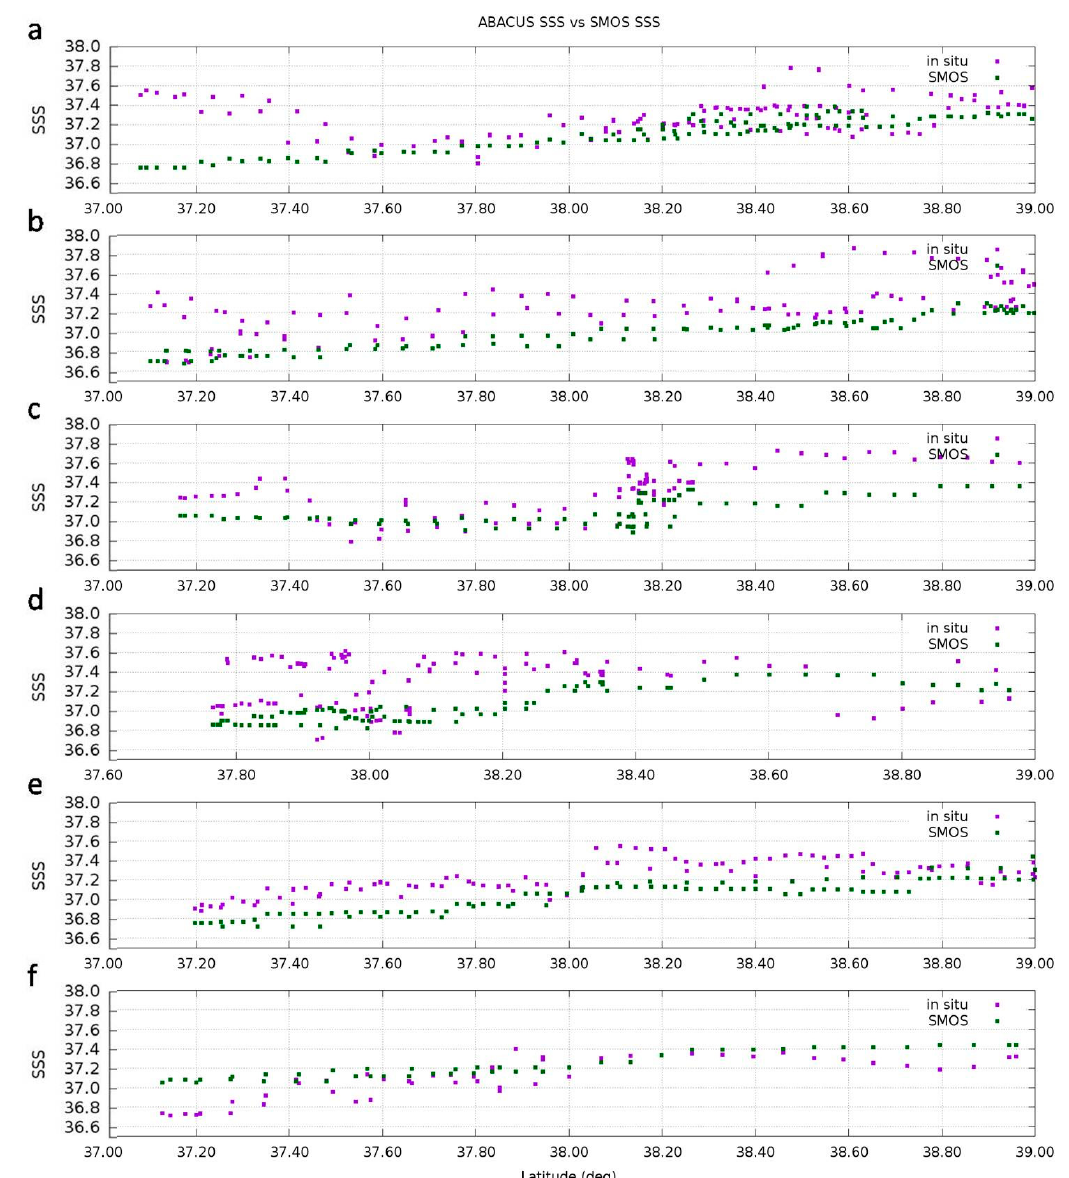
Figure 4. Comparison between averaged in situ glider salinities (purple dots) and SMOS L3 SSS (green dots) along latitude, during the missions ( a ) ABACUS 1.1 (Sept–Oct 2014), ( b ) ABACUS 1.2 (Nov–Dec 2014), ( c ) ABACUS 2.1 (Oct–Nov 2015), ( d ) ABACUS 2.2 (Nov–Dec 2015), ( e ) ABACUS 3.1 (Nov 2016), and ( f ) ABACUS 3.2 (Dec 2016).